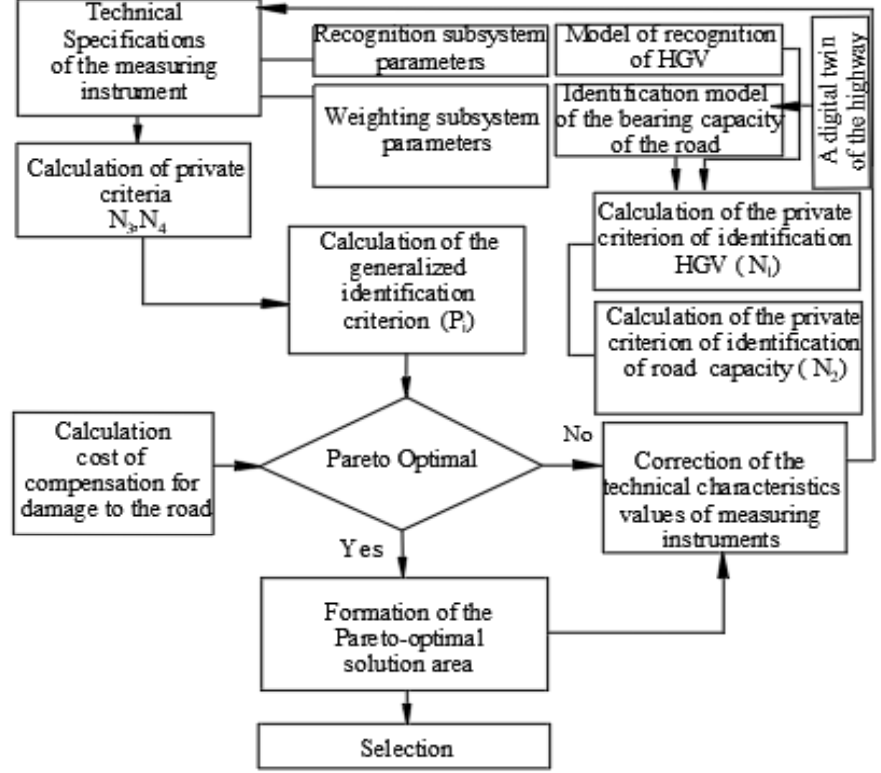
Figure 6. Algorithm of rational choice of measuring instruments of automatic TMTC on the basis of the Pareto method.